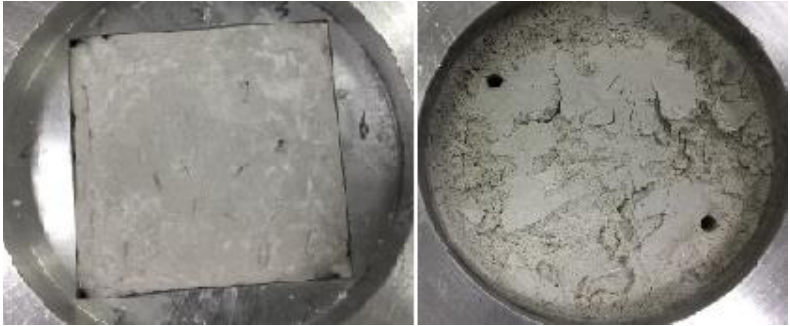
Figure 11. Sediment morphology before and after hydrate dissociation for run 3.